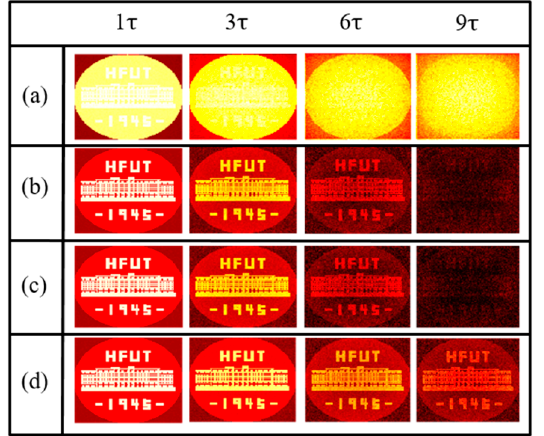
Figure 5. Intensity ( a ); DoP ( b ); PD ( c ); and PR ( d ) imaging results under the four scattering media with different optical thickness of 1 τ , 3 τ , 6 τ , and 9 τ , respectively.